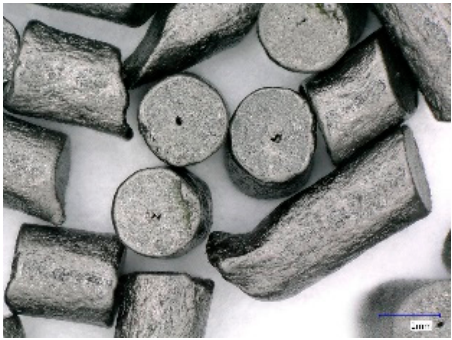
Figure 4. Image of NC1214 grains.